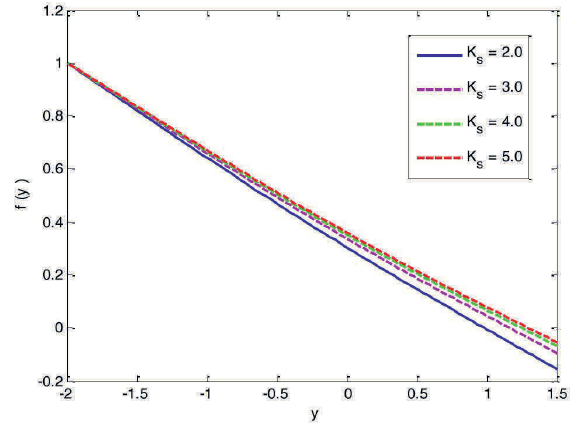
Fig. 16: Impact of radiation parameter R on temperature.